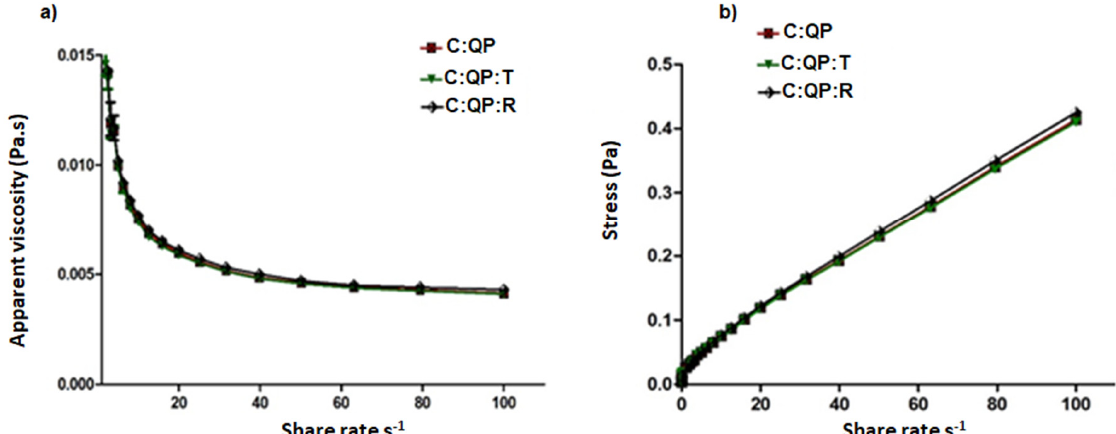
Figure 5. Rheology of filmogenic suspensions C:QP, C:QP:T, and C:QP:R. ( a ) Apparent viscosity vs. shear rate; ( b ) Stress vs. shear rate. QP: quinoa protein; C: chitosan; T: essential oil of thyme; A: rosemary essential oil. Data are presented as the mean ± standard deviation.